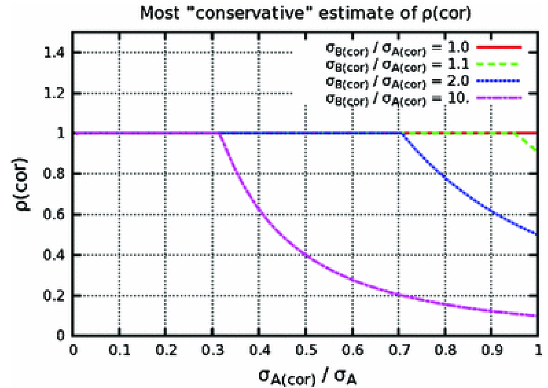
Figure 2. The most “conservative” value of an unknown correlation ρ (cor) between σ A (cor) and σ A (cor) as a function of σ A (cor) /σ A , for several values of σ B (cor) /σ A (cor) ≥ 1. The figure is from ref.